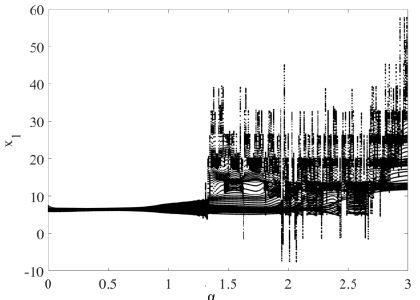
γ = γ= ). Figure 1. Bifurcation diagram of chaotic System ( 1 ) (